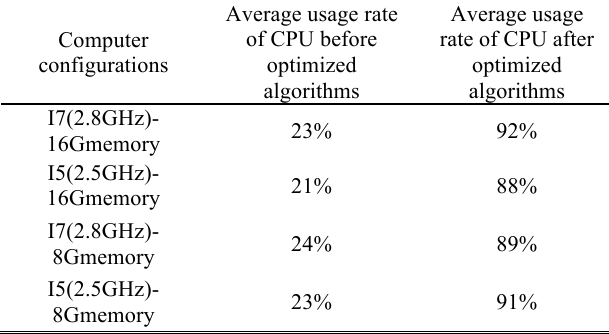
Table 1. Average usage rate of CPU before and after optimized